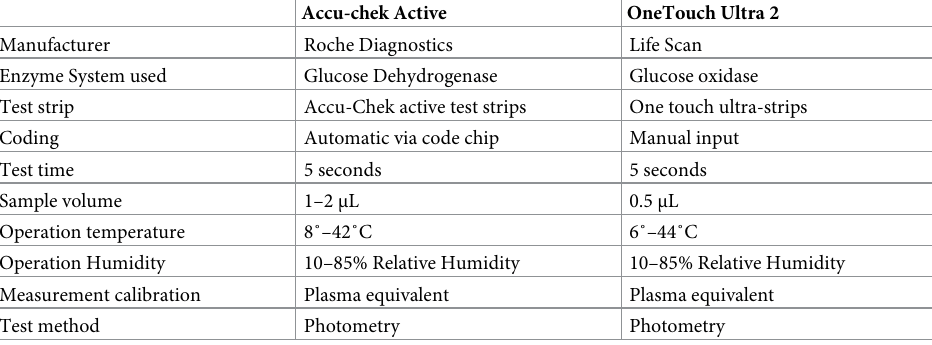
Table 1. Glucometers used and their